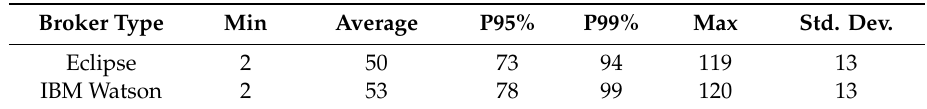
Table 4. Statistics of the D CS (Delay from Cloud user application to Subscriber) collected in the experiments. All values are in milliseconds.